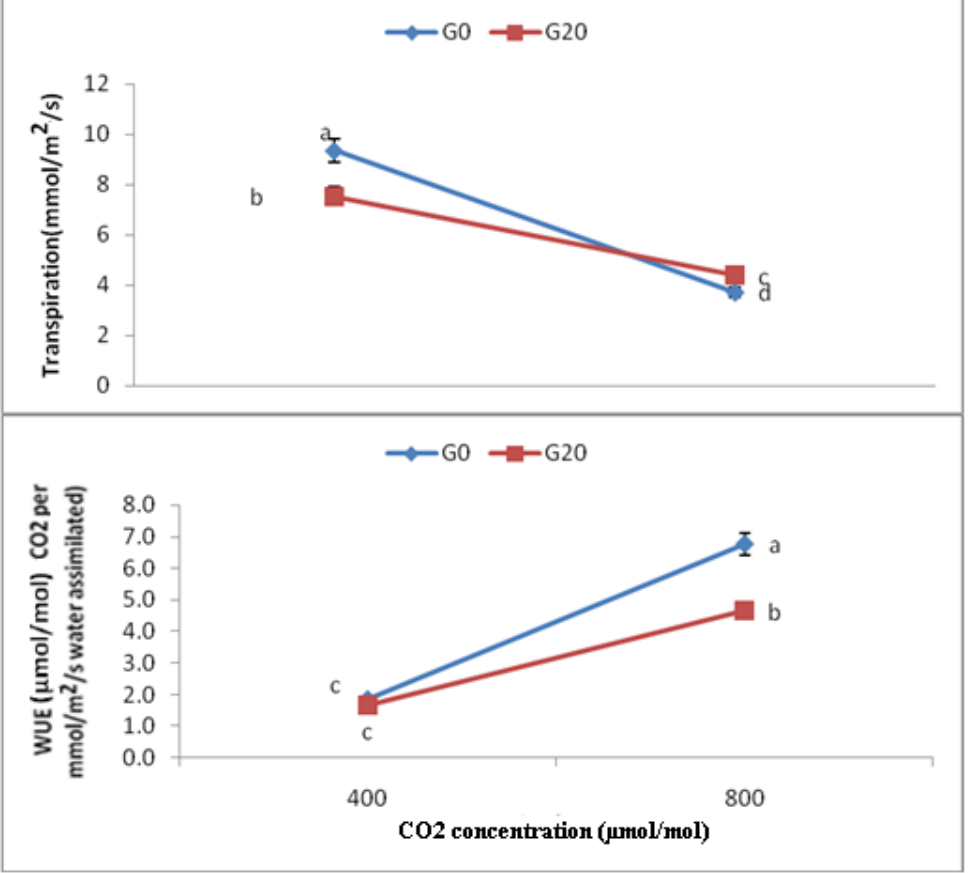
Figure 5. Effects of different CO